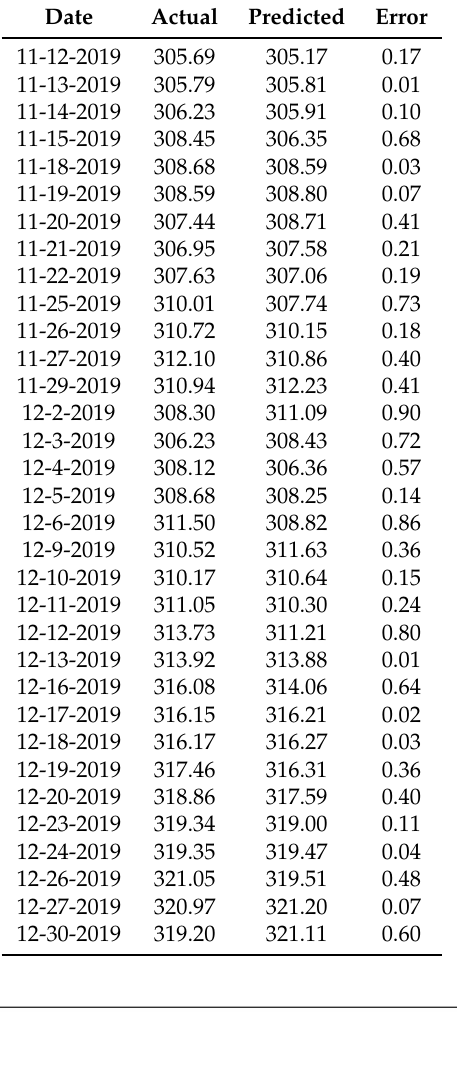
Table 6. Prediction by geometric Brownian motion.